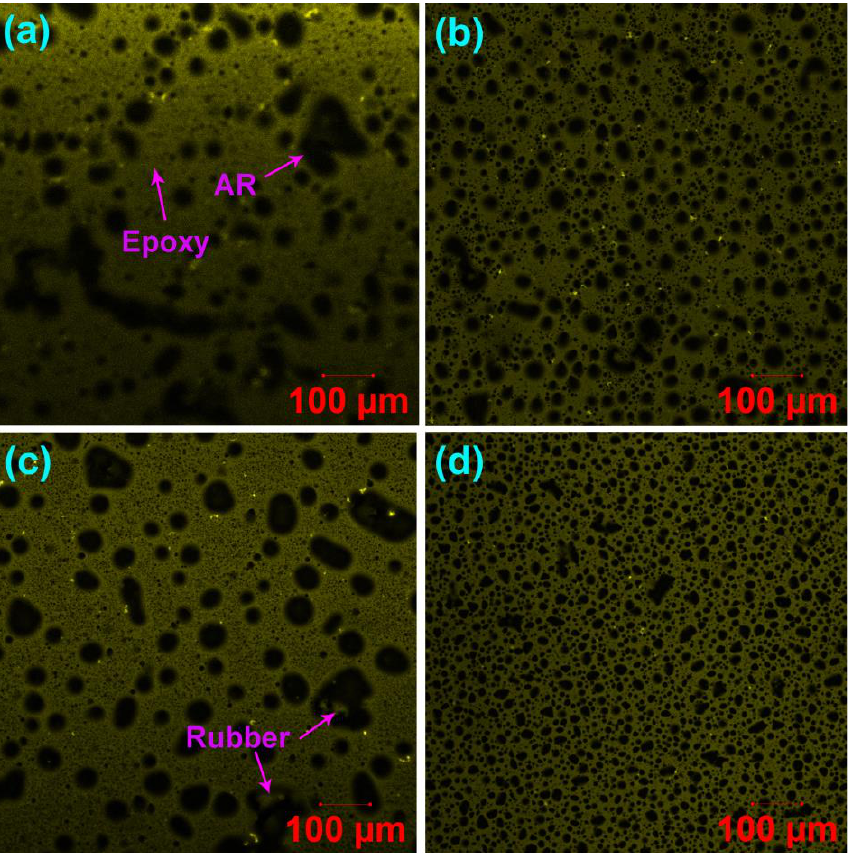
Figure 8. Fluorescence laser confocal microscopy images of ( a ) the unmodified EAR binder and modified EAR binders containing different WCO concentrations: ( b ) 2%, ( c ) 4% and ( d ) 6%.